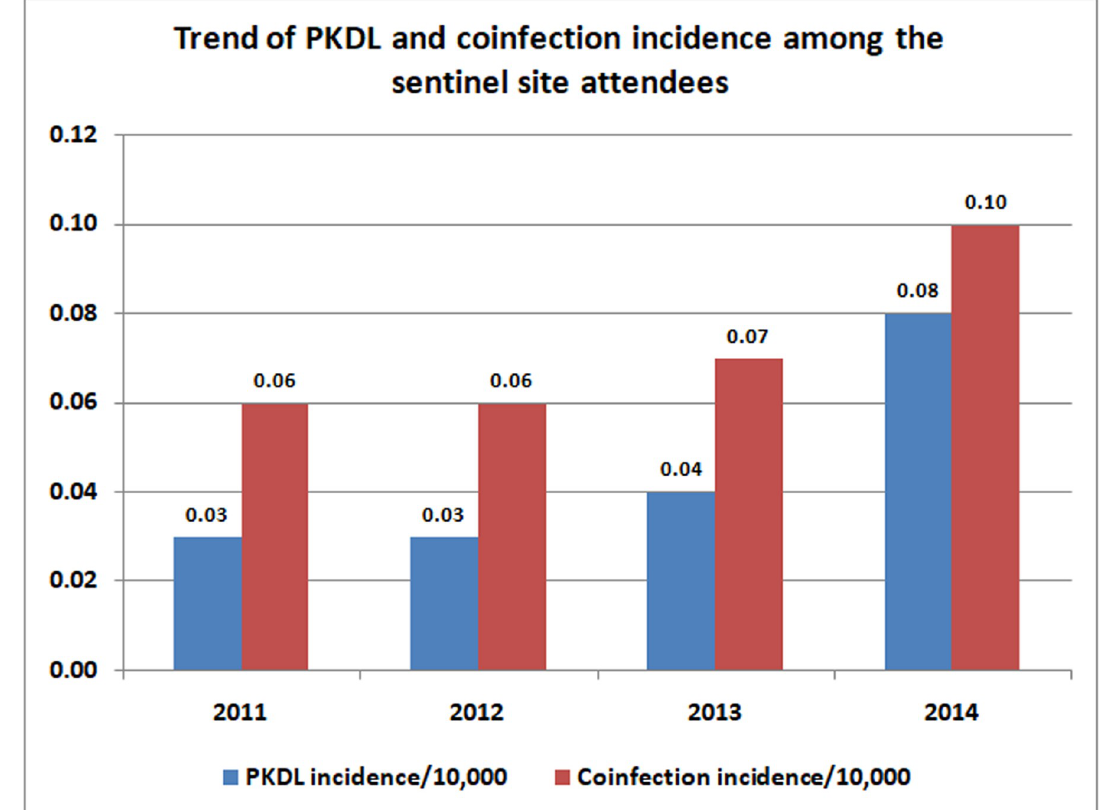
Fig 2. Trends of PKDL and co-infection incidence among the sentinel site